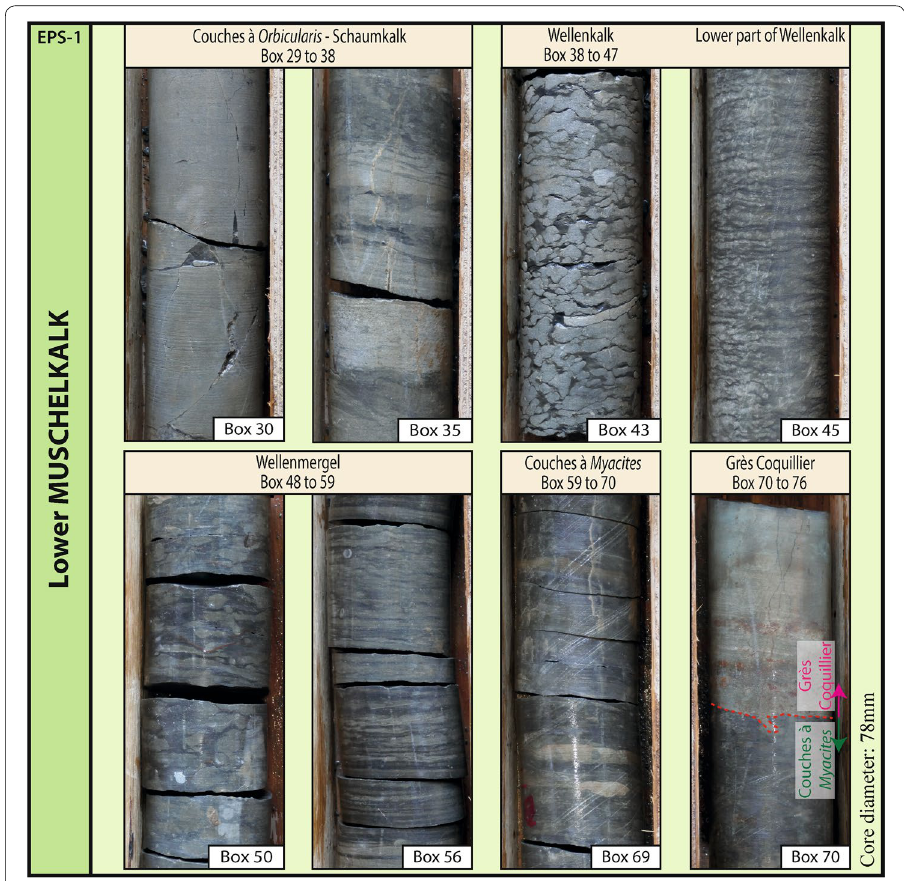
Fig. 5 Photo board of the cores from the lower Muschelkalk, with the Box associated with the cores; this package is correlated to a formation (with the names and boxes concerned). All the cores have a diameter of 78 mm. Box 30 corresponds to the Couches à Myophoria Orbicularis composed of massive dolomite, alternating between dolomicrite and dolosparite, with marl content. Box 35 corresponds to the Schaumkalk composed of dolomite (generally dolomicrite) alternating with clays (in dark, wavy and bioturbated). Boxes 43 and 45 correspond to the Wellenkalk formation, where dolomite alternates with millimetric marls and silty marls, with the whole facies as wavy to lenticular bedding interpreted as tidal deposits. The lower part of the formation (Box 45) marks the passage from wavy to lenticular bedding. Boxes 50 and 56 correspond to the Wellenmergel formation, a centimeter-scale dolomite laminae interbedded with centimetric bioturbated marls. Box 69 corresponds to the Couches à Myacites formation composed of marls intercepted by fine dolomites, sandy dolomites, and sometimes sandstone beds. Box 70 corresponds to the Grès Coquillier composed of sandstones with few clayey and silty marls